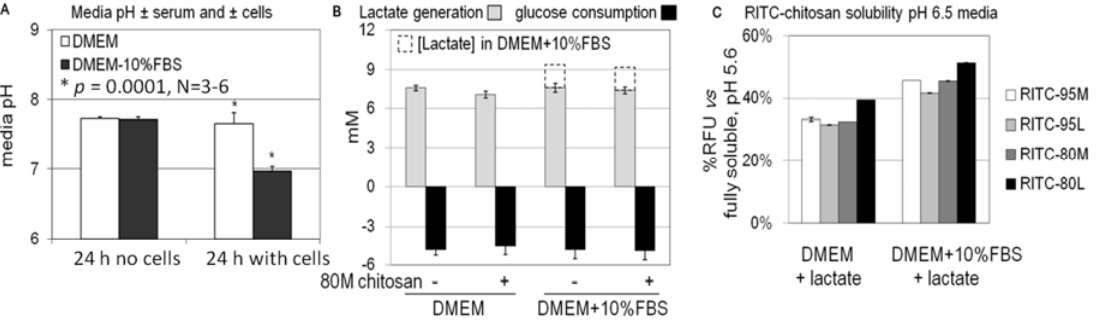
Figure 10. Media pH ( A ), and corresponding 7 mM lactate generation and 5 mM glucose consumption after 24 h of incubation at 37 °C with and without serum ( B ). RITC-chitosan added to lactate-acidified media pH 6.5 remained 30% to 50% soluble compared to RITC-chitosan fully soluble in dilute HCl pH 5.6 ( C